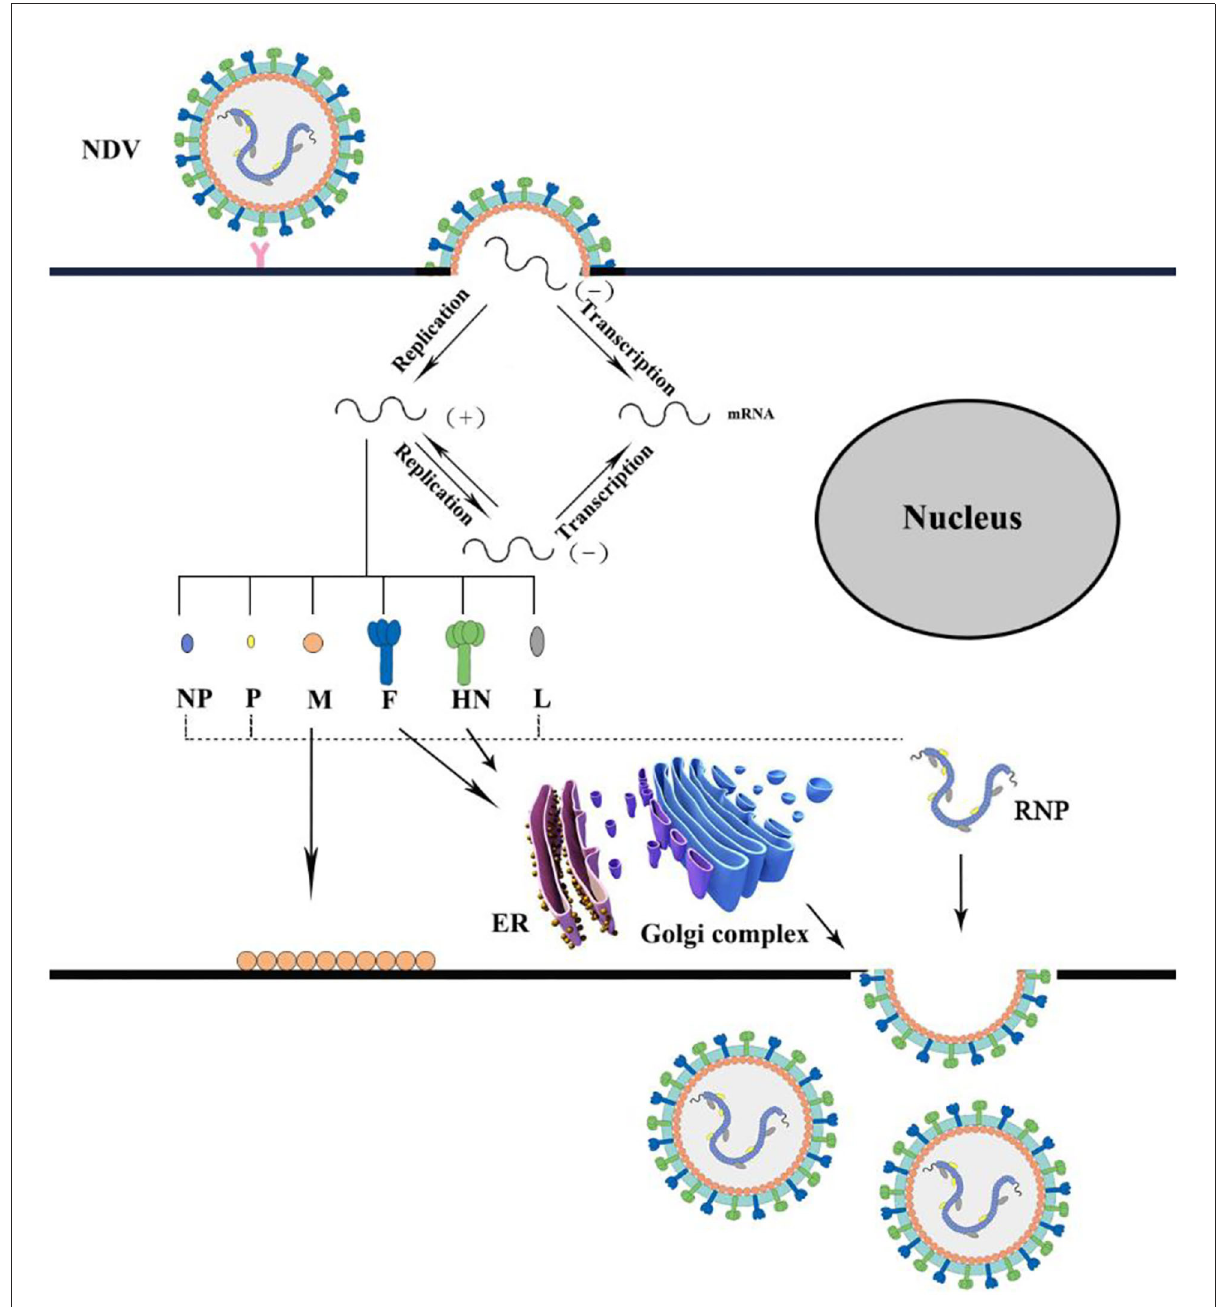
FIGURE3 Schematic representation of Newcastle disease virus replication.